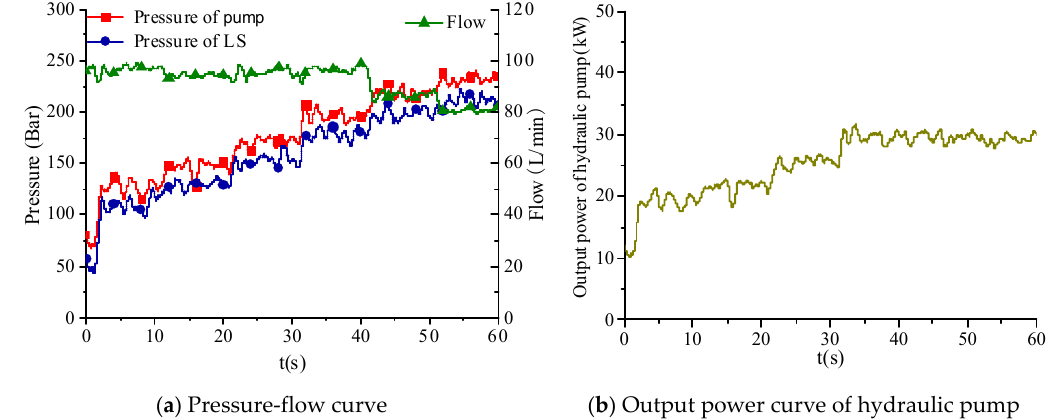
t(s) ( c ) Power of EM Figure 13. Test curve at 30% SOC. 7. Conclusions In this paper, a piecewise constant power control strategy was proposed. The feasibility of the proposed control strategy was verified by simulation and experiment. According to the maximum allowable discharge power of battery at different temperatures and SOC, different maximum power